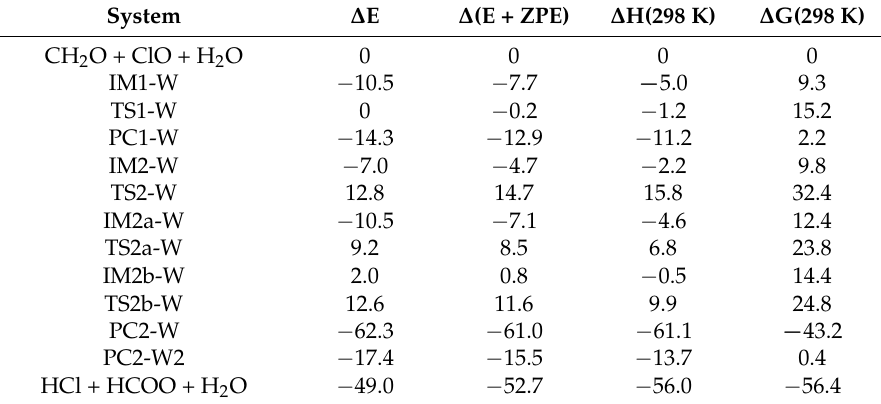
Table 2. Electronic energies ( ∆ E and ∆ (E + ZPE)), enthalpies [ ∆ H(298 K)], and Gibbs free energies [ ∆ G(298 K)] for the reaction beginning with IM1 + H 2 O and IM2 + H 2 O. The units of the energies are kcal mol − 1